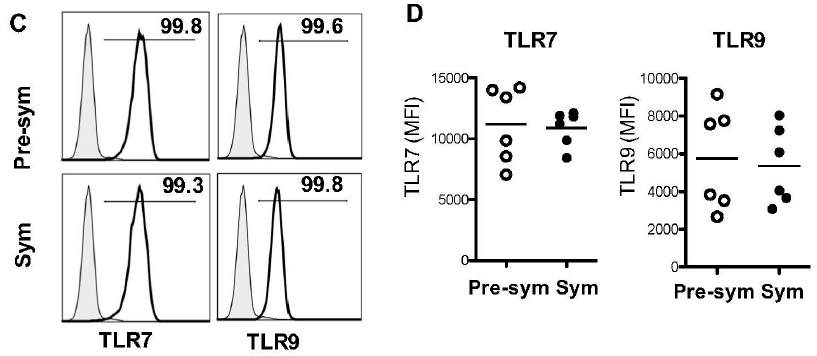
Figure 2. Bone marrow-derived pDCs from pre-symptomatic (Pre-sym) and symptomatic (Sym) lupus mice have similar phenotypes . ( A ) Expressions of MHC class II, CD40 and CD86 in CD11c + B220 hi pDCs derived from day-8 BM culture were analyzed. Representative plots of n = 6–7 is shown; ( B ) Expression of Irf7 , Tlr9 , Tlr7 and Ifitm3 of purified pDCs derived from day-8 BM culture were examined by real time PCR, and were shown as relative quantities (RQ) with reference to the average expression of corresponding genes in the pre-symptomatic pDCs. Collective data of n = 6–7 mice were shown; ( C ) Expressions of TLR7 and TLR9 in BM-derived pDCs on day-8 were analyzed. Numbers shown are percentages of positive cells. Shaded histograms represent isotype antibody staining controls; ( D ) Collective data comparing the mean fluorescence intensity (MFI) of TLR7 and 9 expressed in pre-symptomatic and symptomatic pDCs. Each symbol represents one individual mouse ( n = 6). Data were collected from at least three independent experiments. Bar: mean values; * p ≤ 0.05 (unpaired two-tailed Student’s t -test).